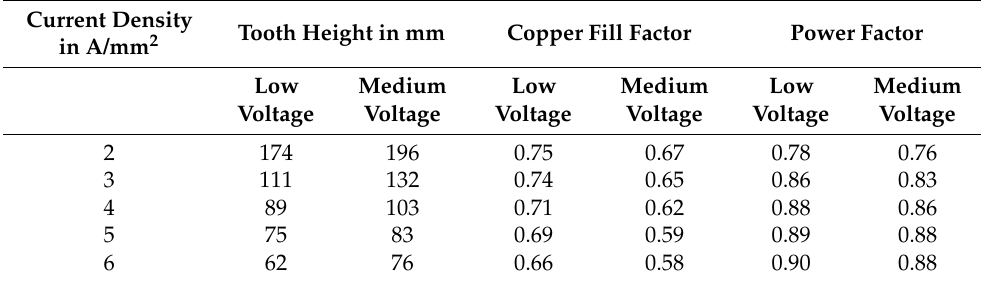
Figure 9. ( a ) FEMAG-DC model considering to the insulation; ( b ) The flux density distribution calculated by FEMAG-DC.